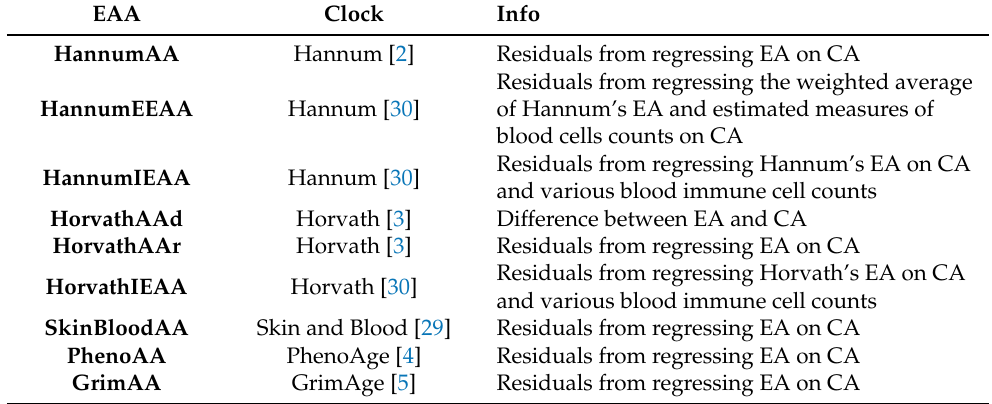
Table 1. Summary of the EAA scores measured using DNA Methylation Online Calculator.